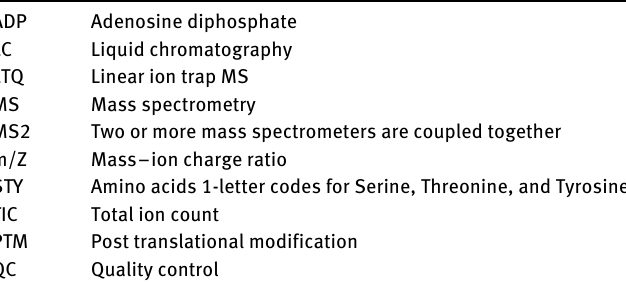
Table 1: List of used biochemistry